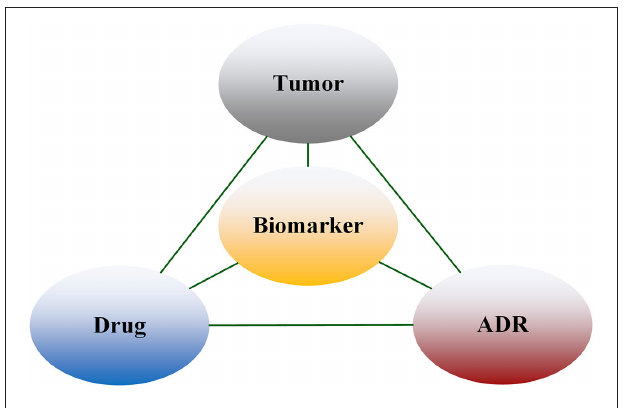
FIGURE 2 | Structure of